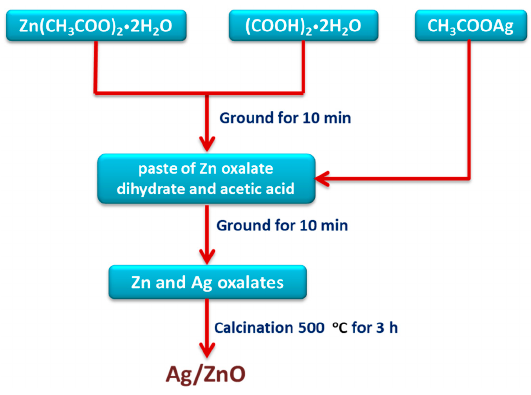
Figure 1. Schematic representation of the synthesis process of Ag/ZnO.